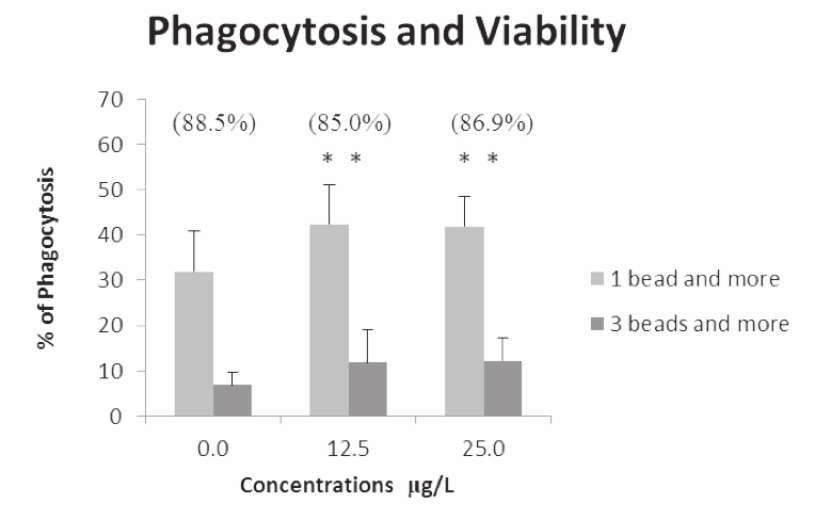
Figure 1. Percentage of viability, phagocytic activity (1 bead and more) and efficiency (3 beads and more) following an exposure of 21 h. Viability was not affected while phago- cytic activity and efficiency were significantly increased when compared to control. **P ≤